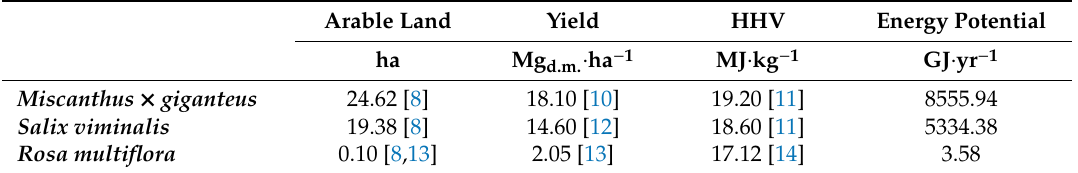
Table 1. The energy potential of selected energy crops in EU28. Arable